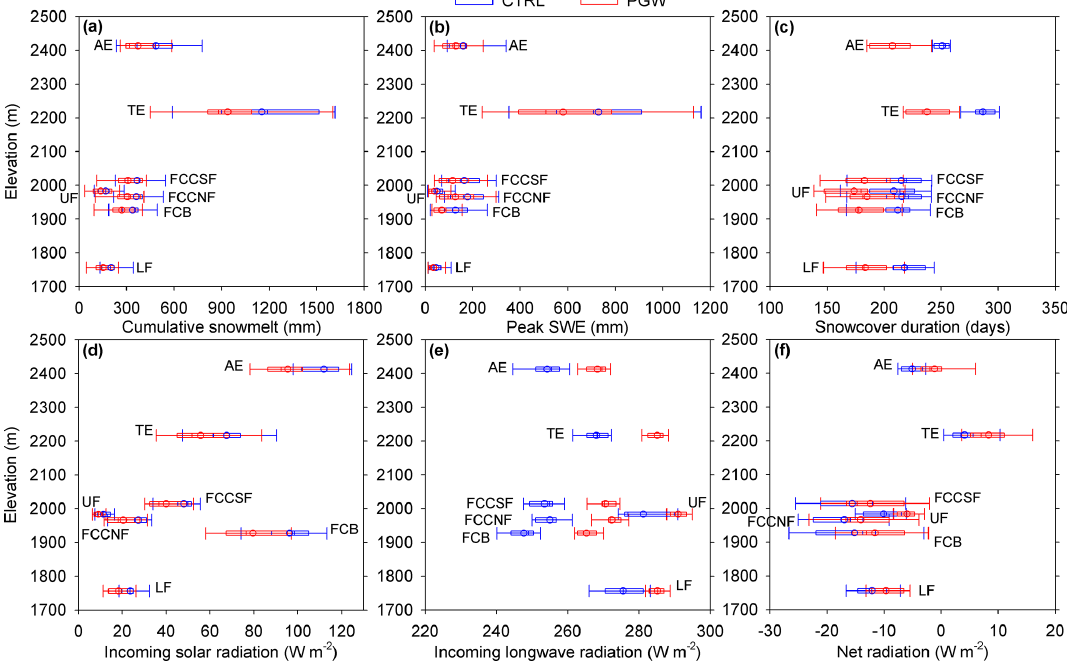
Figure 9. Boxplots of the simulated water year’s (a) cumulative snowmelt, (b) peak snow accumulation (SWE), (c) snow-cover duration, (d) incoming solar radiation to snow, (e) longwave irradiance to snow, and (f) net radiation to snow for WRF CTRL and PGW for the alpine (AE), treeline (TE), upper forest (UF), forest clearing blocks (FCB), forest circular clearing north-facing (FCCNF), forest circular clearing south-facing (FCCSF), and lower forest (LF) ecozones. The vertical line within the box is the median value of the 8 water year data, the box is the interquartile range ( Q 1 : 25% to Q 3 : 75%) of the 8 water year data, the whiskers are the minimum and maximum, and the circle is the mean value of the 8 water year